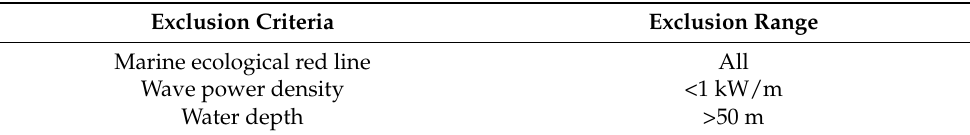
Table 3. Exclusion range of each criterion.